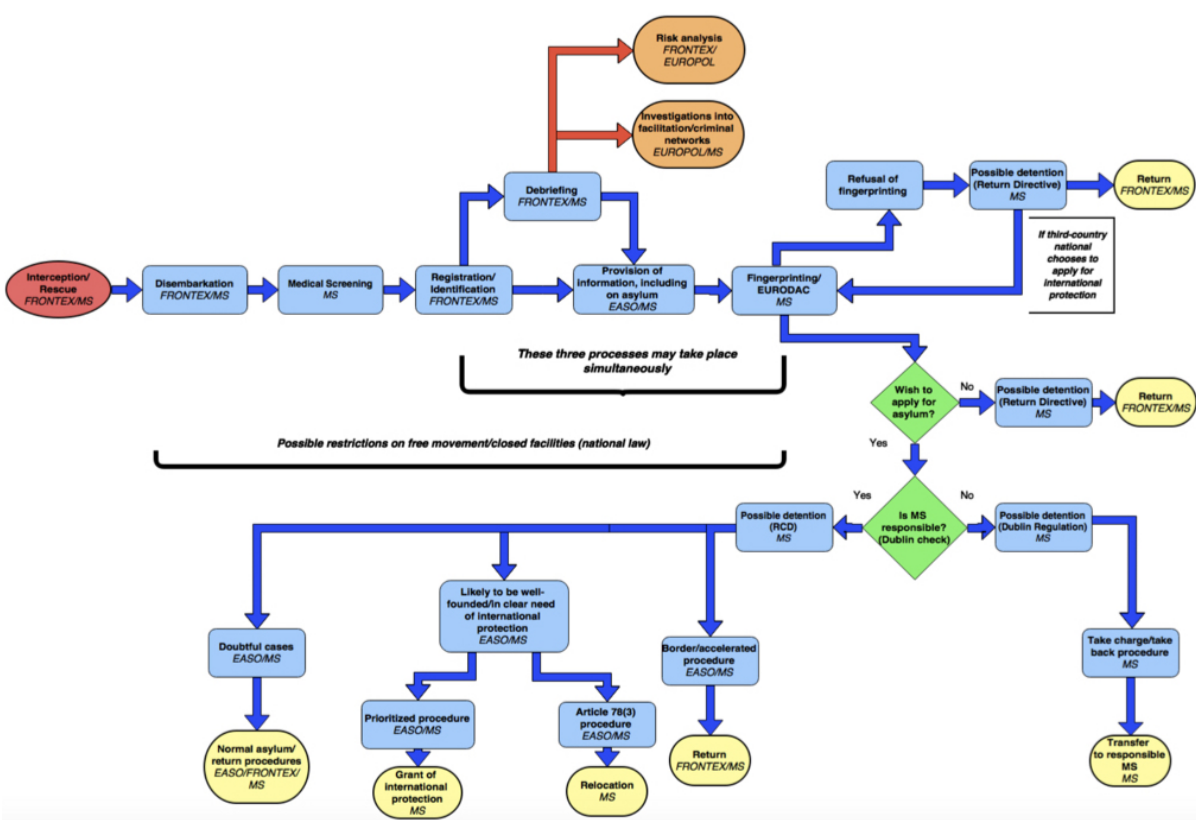
Figure 1. Hotspot approach. Source: EU Commission (2015, p.